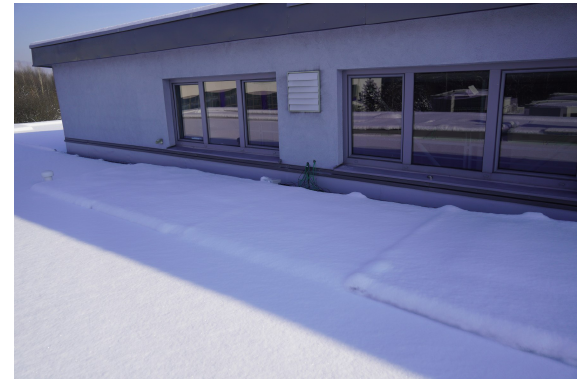
Figure 4. Roof covered with